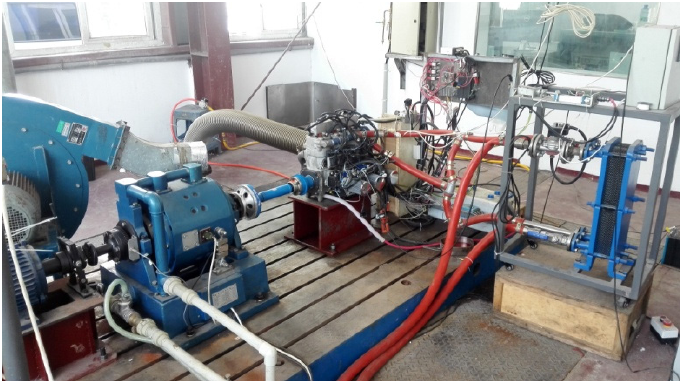
Figure 6. Structure block diagram of the engine test bench.